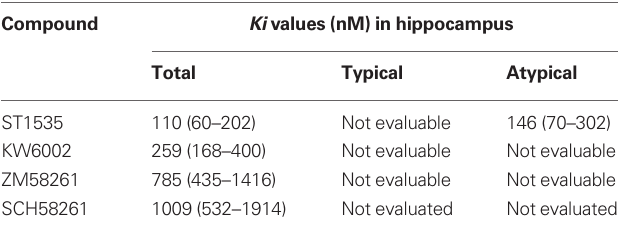
Table 2 | Displacement of [ 3 H]CGS 21680 binding from total, typical and atypical adenosine A receptors in rat hippocampal membranes. 2A